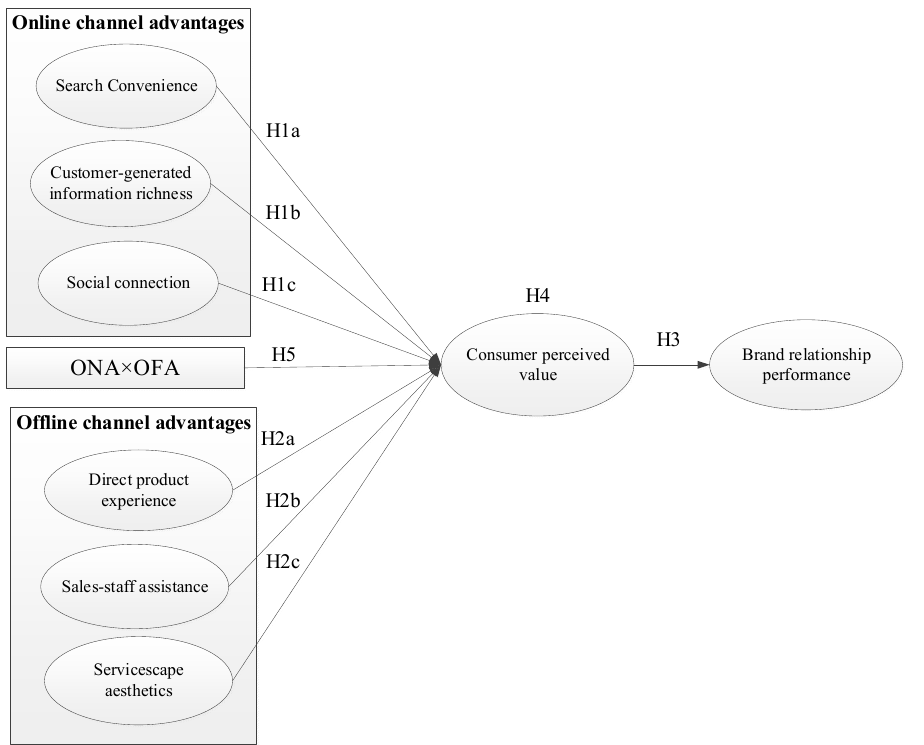
Figure 1. Research model. Note: ONA = online channel advantages, OFA = offline channel ad- vantages.